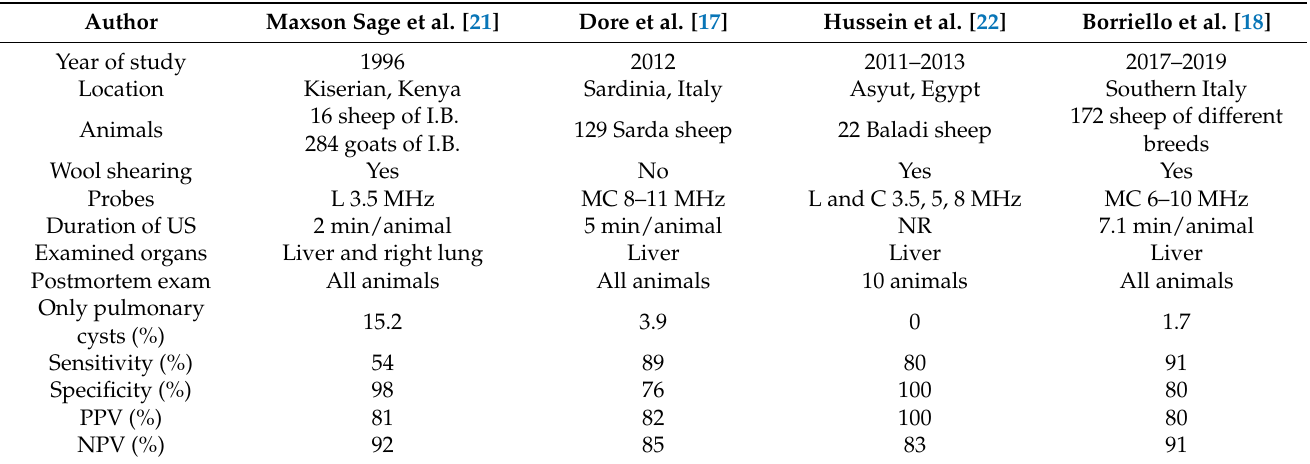
Table 2. The diagnostic accuracy of ultrasonography in diagnosing cystic echinococcosis in sheep and goats reported by different